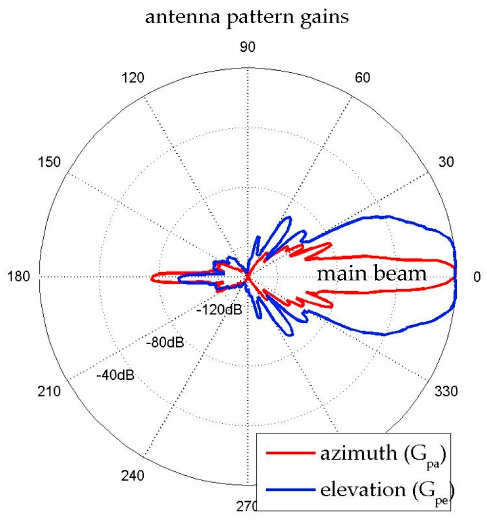
Figure 5. Antenna pattern of the K-MC3 transceiver module. The antenna’s 3 dB beam widths in azimuth and elevation are seven degrees and 25 degrees, respectively.